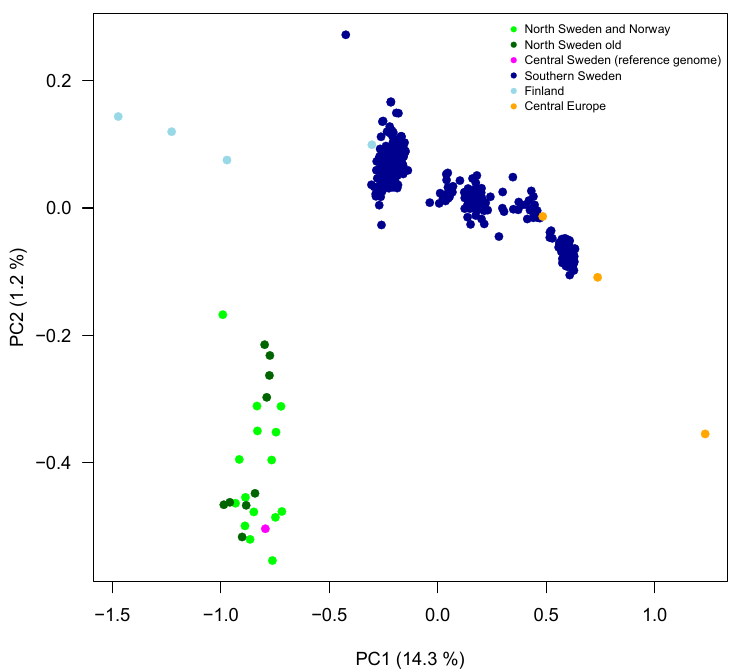
Figure 1. Population structure in probe regions.